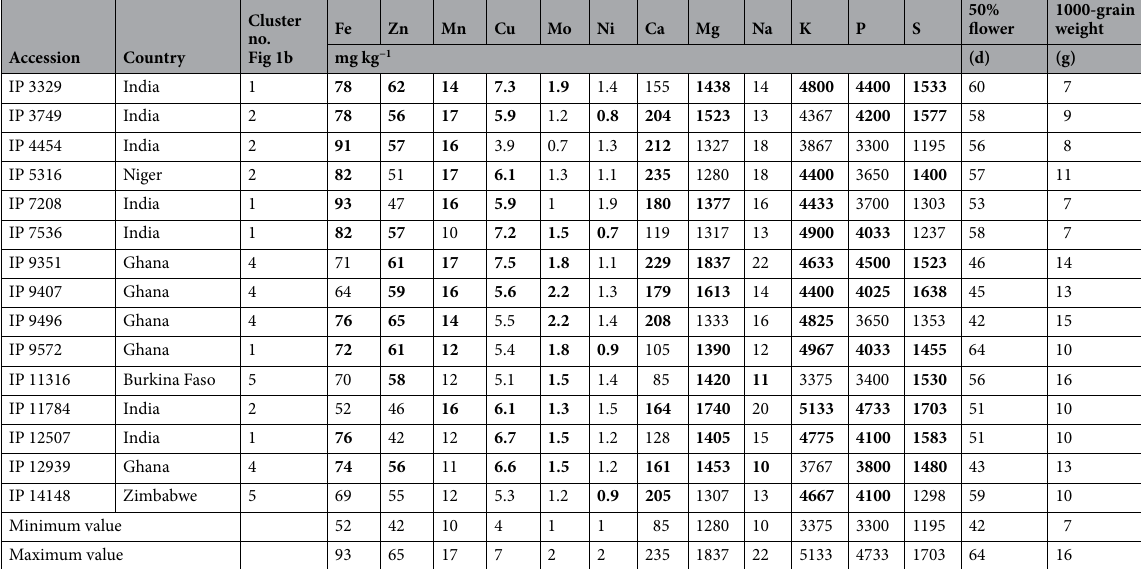
Table 1. Core collection accessions with high values of multiple nutritional traits s based on evaluations in the 2011 summer and 2011 rainy seasons, Patancheru, India. Values in bold indicate higher levels of multiple nutrients except for Ni and Na where the lowest is